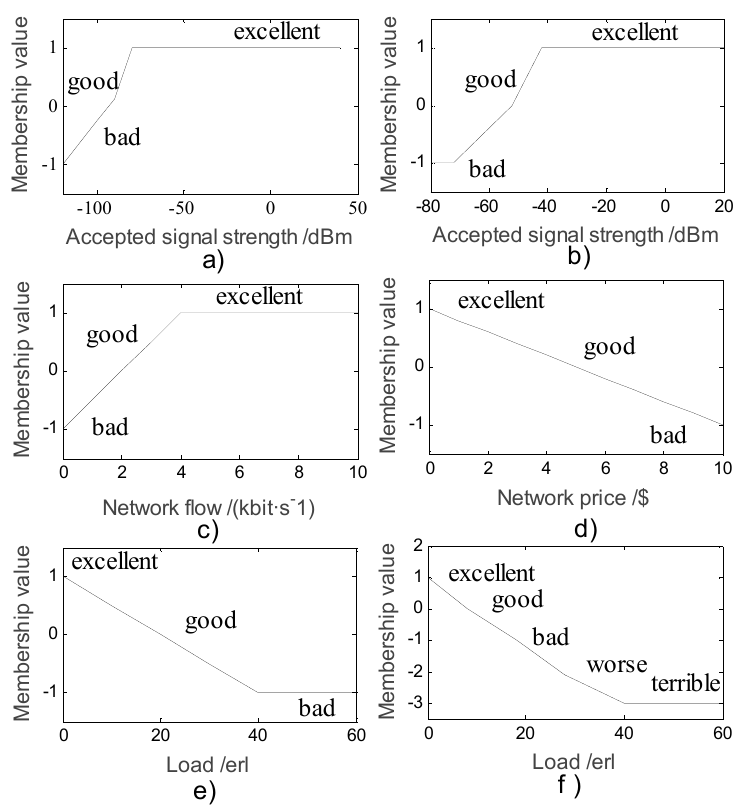
Output Figure 3. The uncertainty membership processing